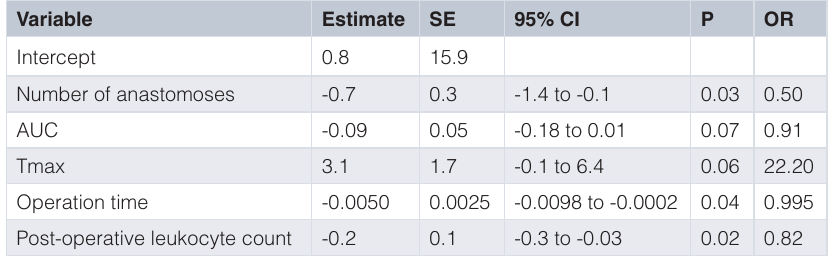
Table 4. Model predicting the odds ratio for no leaks versus leaks.